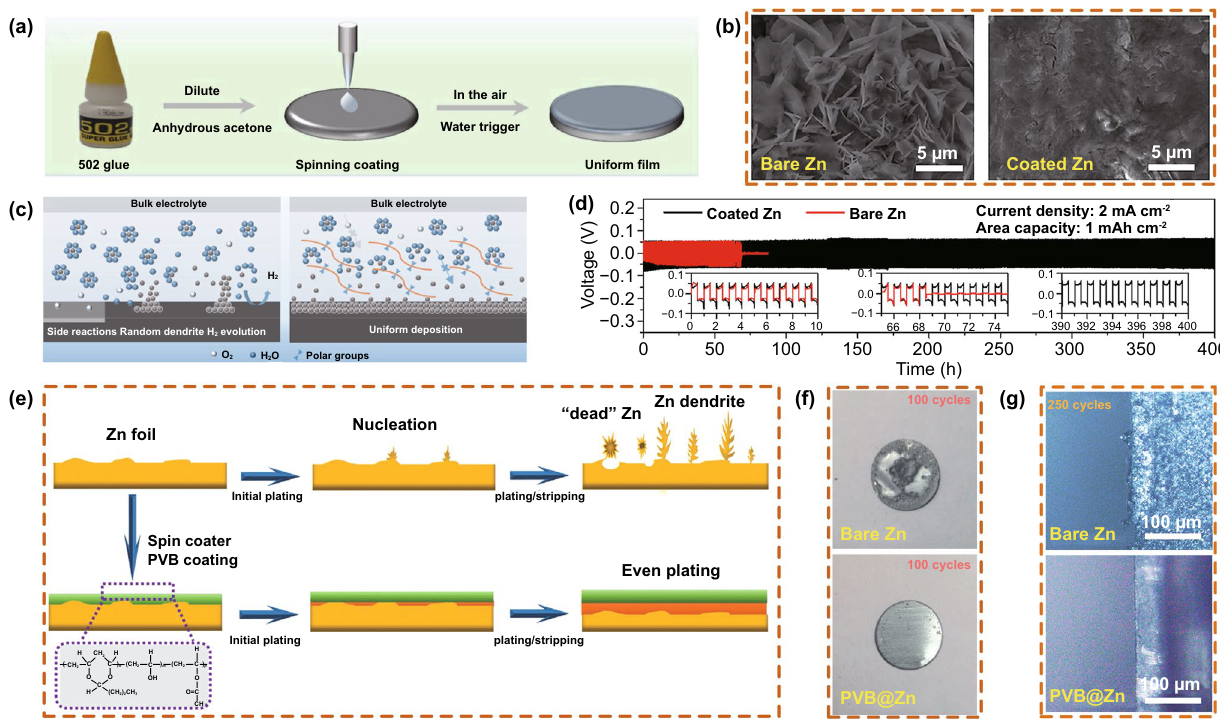
Fig. 11 a Schematic diagram of the preparation of a 502 glue protective layer. b Morphology of bare ZF and 502-decorated ZF obtained from symmetrical Zn cells after Zn stripping/plating for 100 cycles at 0.5 mA cm −2 for 0.25 mAh cm −2 . c Schematic diagram of the mechanism of 502 glue for suppressing Zn dendrite. d Long-term cycling stability for symmetrical cells with various current densities and capacities. Copy- right 2020 Elsevier [102]. e Schematic illustration of the morphological evolution for both a bare Zn and PVB@Zn symmetrical cell during repeated stripping/plating cycles. f Digital images of Zn and PVB@Zn electrodes that were stripped out of the cells after 100 cycles. g Zn elec- trodes and PVB@Zn electrodes in symmetrical transparent cells, along with the specified numbers of plating/stripping cycles. Copyright 2020 Royal Society of Chemistry [103]